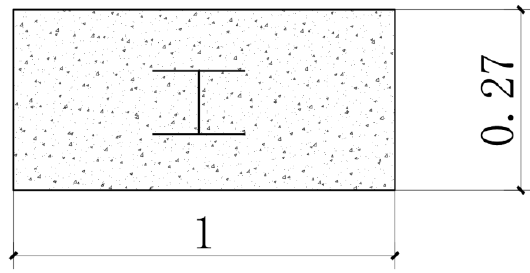
Figure 6. Diagram of the initial support calculation.